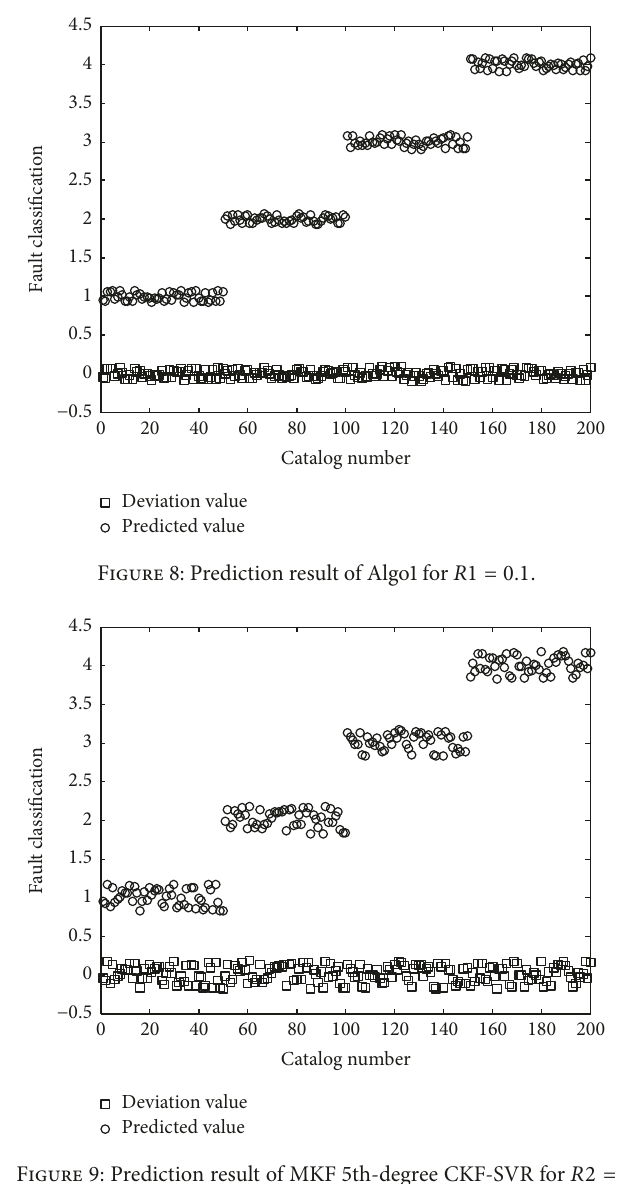
Figure 9: Prediction result of MKF 5th-degree CKF-SVR for 𝑅2 = 0.3 .